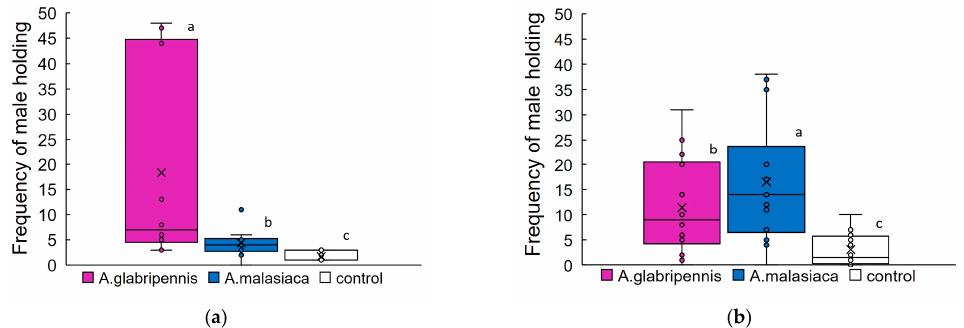
Figure 3. Box-plots of frequencies of ( a ) A. glabripennis males holding onto glass models that were coated with A. glabripennis or A. malasiaca female extracts (Bioassay 2, N = 10); and ( b ) A. malasiaca male holding onto glass models that were coated with A. glabripennis or A. malasiaca female extracts (Bioassay 2, N = 14). Female extracts were coated with 0.2 female equivalent. Control: glass models that were coated with solvent only. Box-plots: middle line, mean; boxes, 75 and 25% quartiles; x, average; whiskers, maximum and minimum values; o, outliers. p < 2.2 × 10 16 , GLM, Poisson (log). Frequencies were analyzed using Tukey’s multiple comparison test with Bonferroni’s correction at p < 0.01. Different letters indicate significant differences.